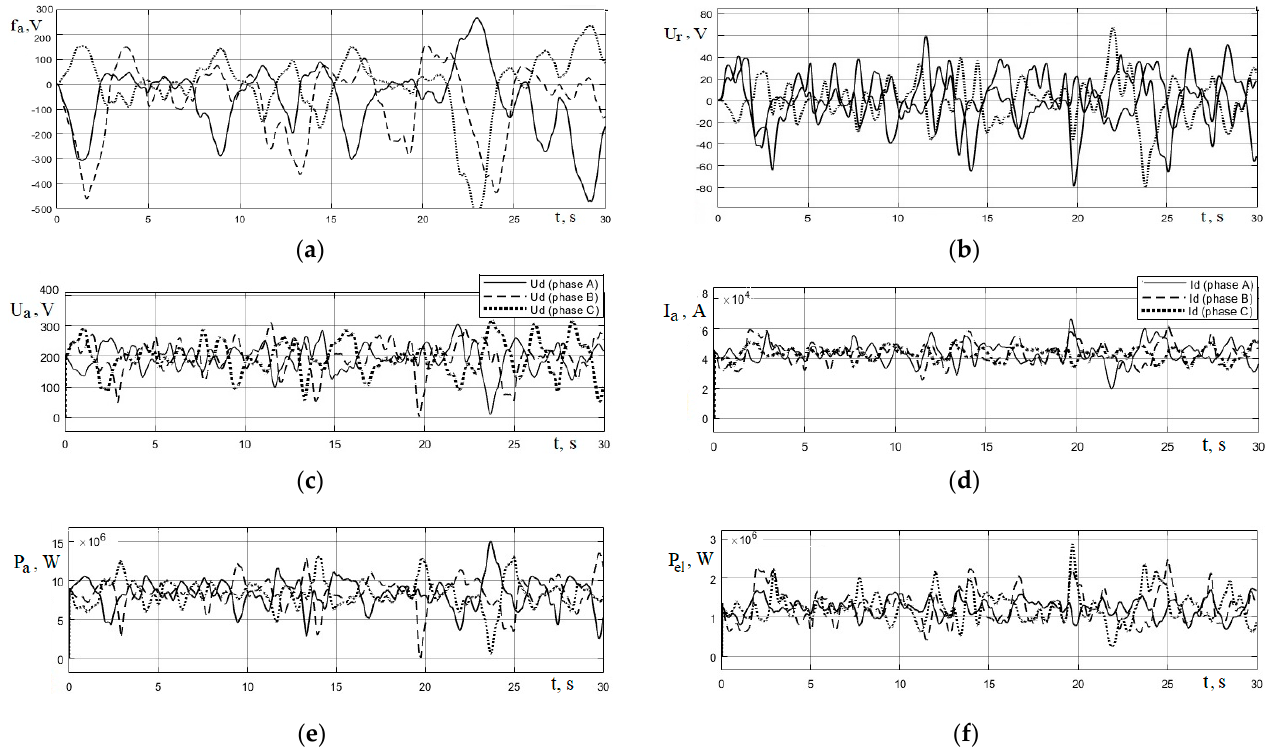
Figure 13. Time dependences of random perturbations: ( a ) mismatch signals; ( b , c ) voltages; ( d ) cur- rents; ( e ) power of arcs; ( f ) power of electric losses when using differential model (1) (ARDM-T-12) for first technological stage of melting.